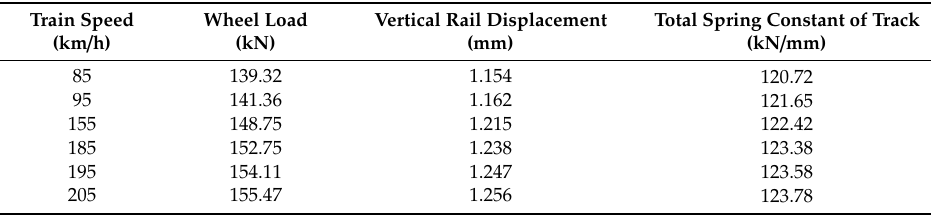
Table 11. Total spring constant of concrete track (FEM).